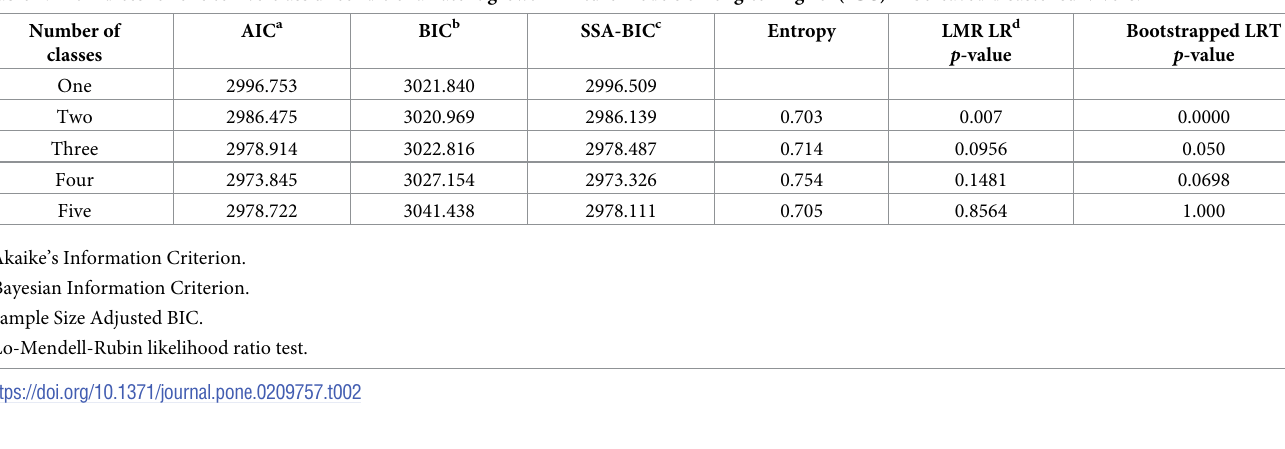
Table 2. Fit indices for one to five-class unconditional latent growth mixture models of long-term grief (ICG) in bereaved disaster